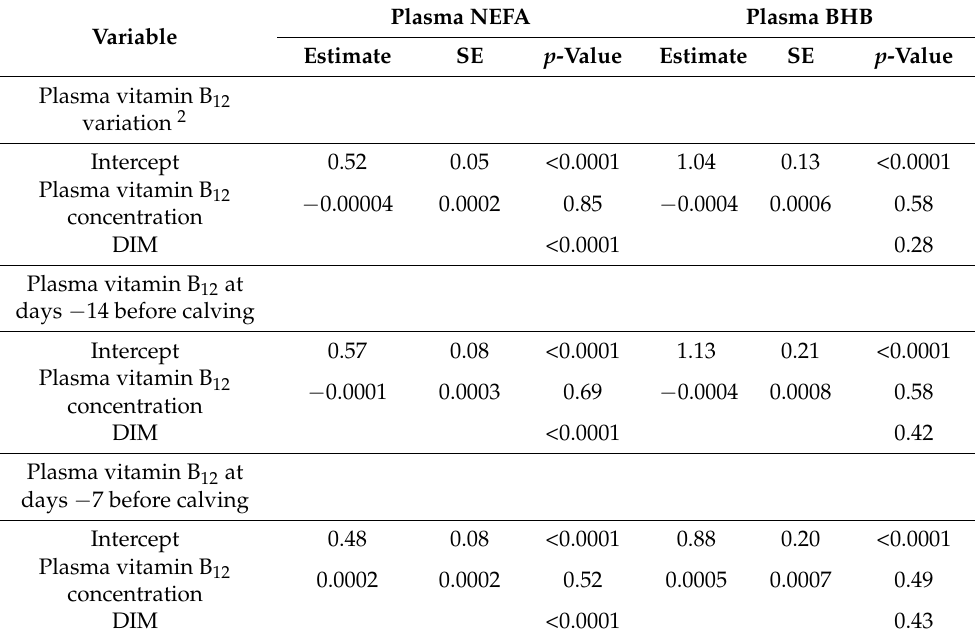
Table 4. Relationships between postpartum plasma NEFA and BHB concentrations 1 and prepartum plasma vitamin B 12 concentration and its variation from − 14 to 21 DIM.